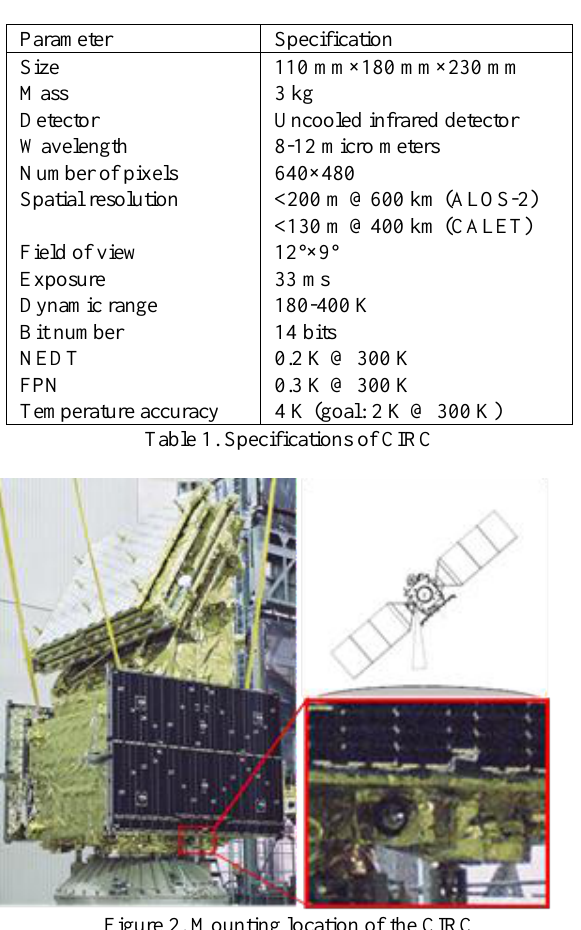
Figure 2. Mounting location of the CIRC